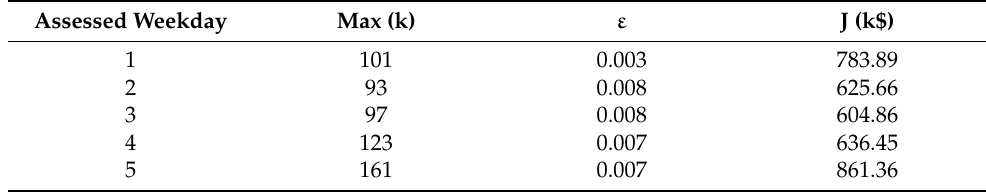
Table 2. Results obtained through the conventional LR.